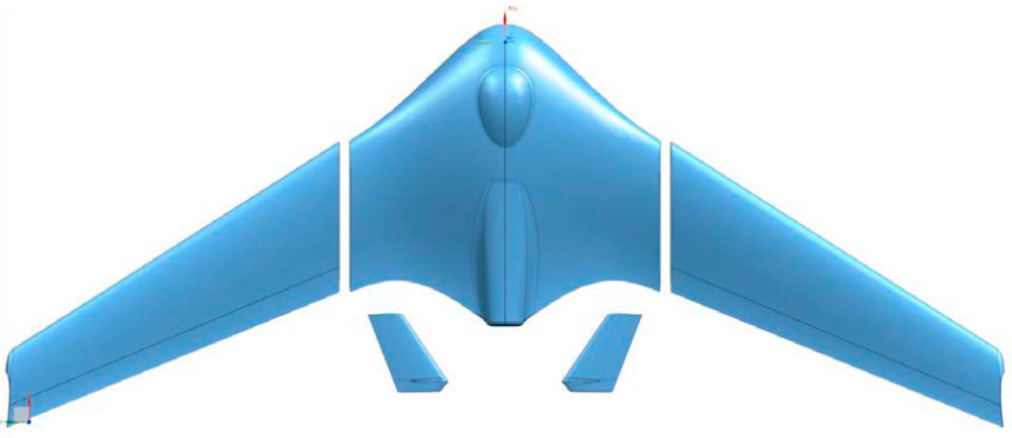
Figure 7. Main and secondary structural modules of flying wing UAV.